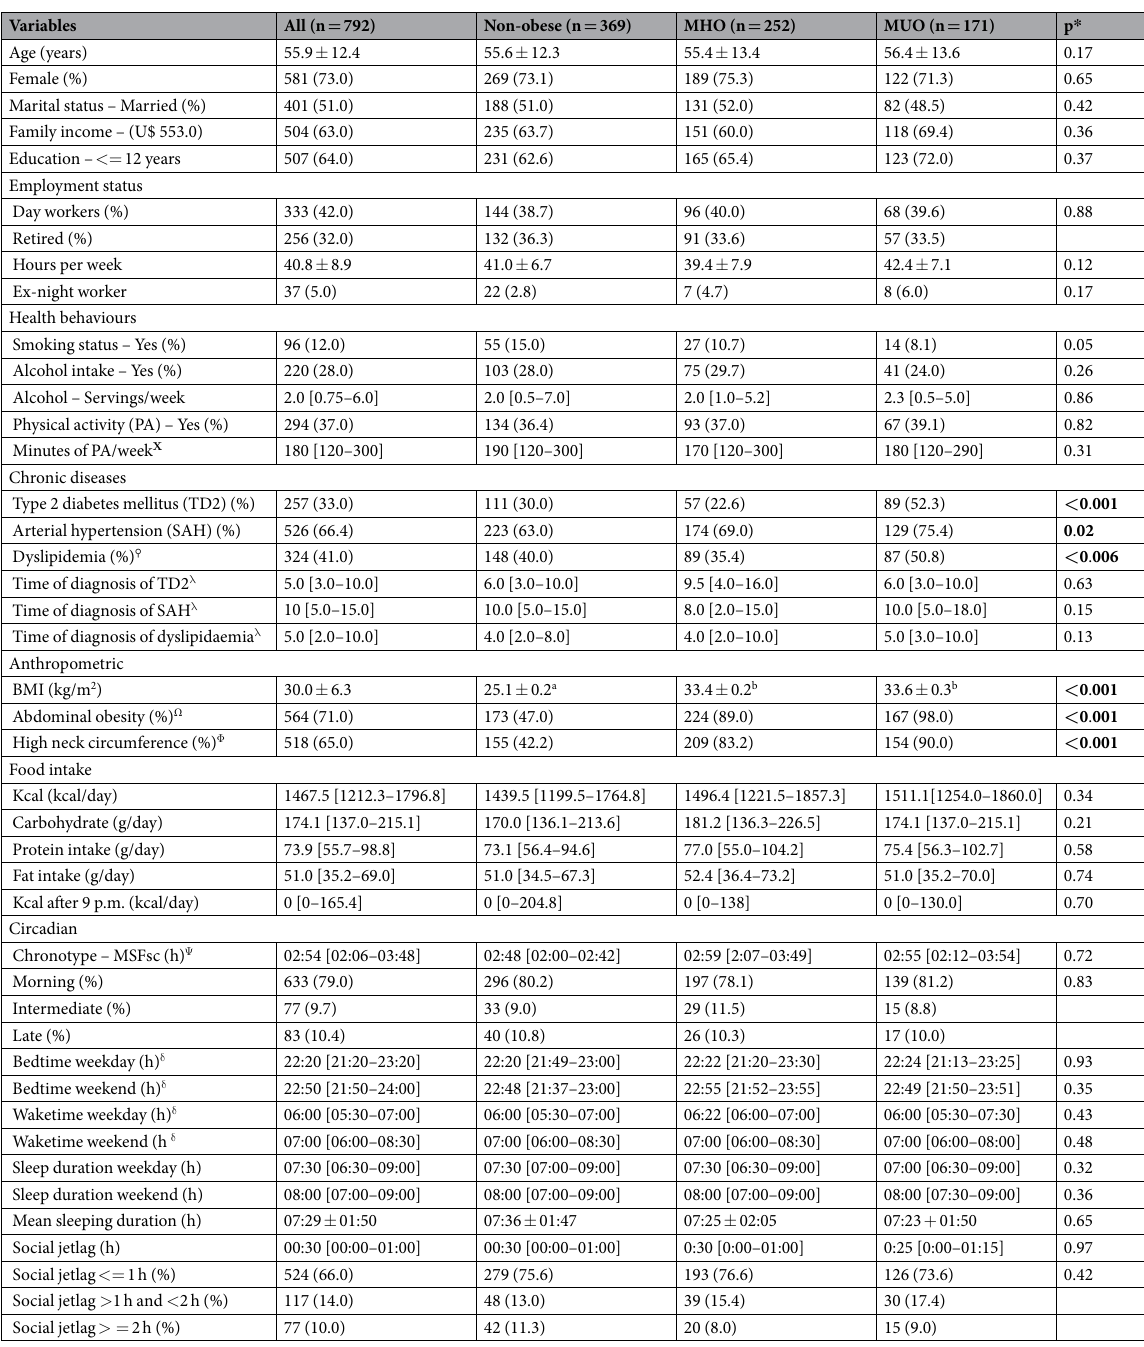
Table 1. Demographics, employment status, anthropometric, health behaviors, physical activity, sleep, social jetlag and metabolic variables according to obesity status (n = 792) * One-way ANOVA and Tukey post hoc analyses were performed for normally distributed variables. When the variables were not normally distributed, Kruskal– Wallis tests were used. Variables with significant values in the Kruskal–Wallis test were tested by Dunn’s test with a correction of alpha via Bonferroni’s method. Values are presented as mean and SD for normally distributed data or as median (interquartile range) for non-normally distributed data. Ψ Chronotype (MSF) was derived from time of mid-sleep on free days (weekend), with further correction for calculated sleep debt – the difference between average sleep duration at weekends and on weekdays. δ Time is presented in 24-h clock time. ⚲ Diagnosis of hypercholesterolaemia, hypertriglyceridaemia or reduced HDL-C. Ω Waist circumference ≥ 102 cm for men and ≥ 88 cm for women were considered abdominal obesity. Φ Neck circumference ≥ 39 cm for men and ≥ 35 cm for women were considered high. λ Only those reported to have type 2 diabetes mellitus, systemic arterial hypertension or dyslipidaemia were included. Χ Only those reported to perform physical activities. BMI: Body mass index. MHO: Metabolically healthy obese. MUO: Metabolically unhealthy